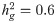
The advantage of B-LORE does not depend on the number of loci used for estimation.Panels (a)—(d) show results from simulations using 25, 50, 75 and 100 loci respectively. As described in the main text, we used 13082 samples and each locus had ∼200 SNPs. All simulations used total heritability of hg2=0.6 and hence the heritability per locus is different for the different panels. We compared the ranking of SNPs at each locus using recall (solid lines, left y-axis) and precision (dotted lines, right y-axis), which were averaged over the loci and the simulation replicates. All methods were run with a maximum of two causal SNPs per locus. Different panels show the results at different number of loci. Insets schematically compare logistic model with linear model in one simulation (see Fig 1 for details). The heritability per locus increases when the number of loci is reduced. Multiple regression becomes increasingly better than single SNP analysis, but the advantage of B-LORE over other multiple regression methods does not change with the number of loci. Note also that the comparison between logistic model and the linear model in the insets does not change with the number of loci.